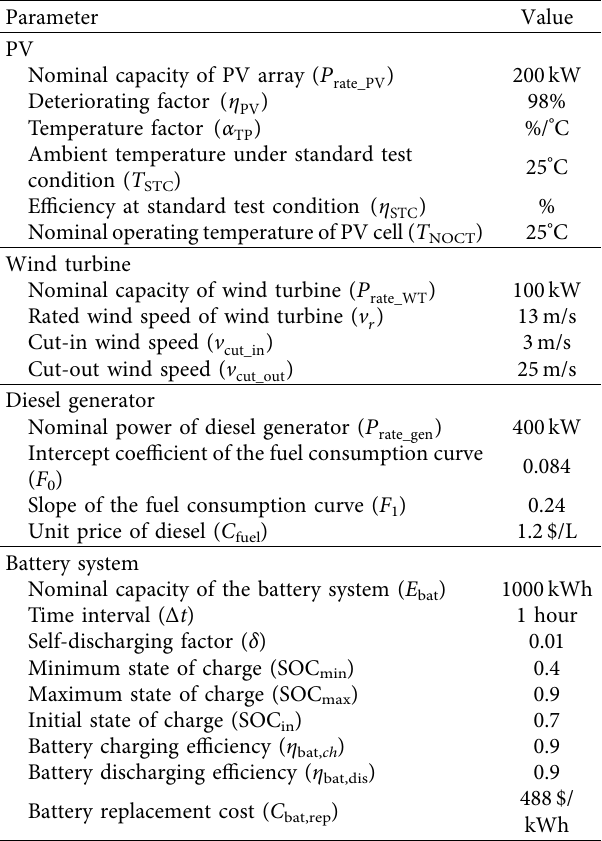
Table 7: The calculation results of method 1.